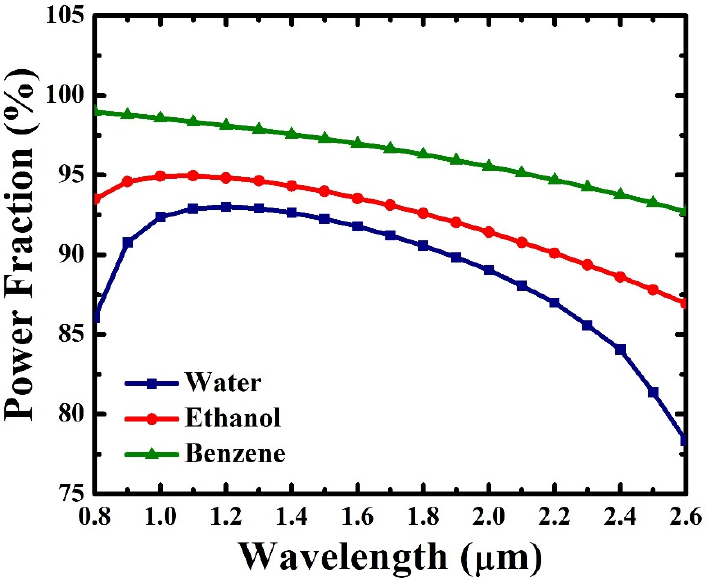
Figure 6. Power fraction of the PCF sensor with respect to wavelength for water, ethanol and benzene.